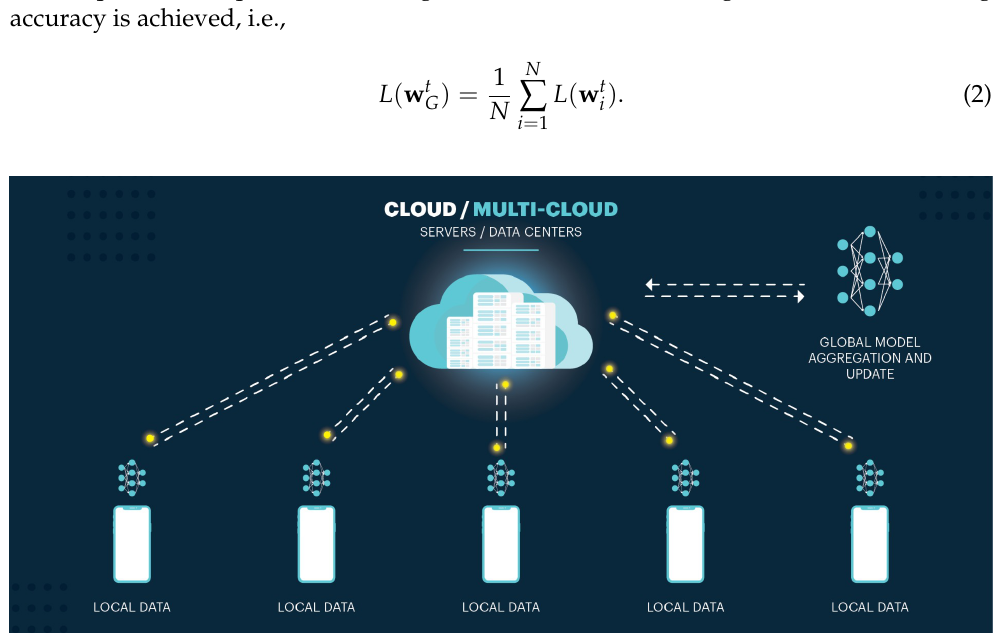
Figure 3. Federated Learning